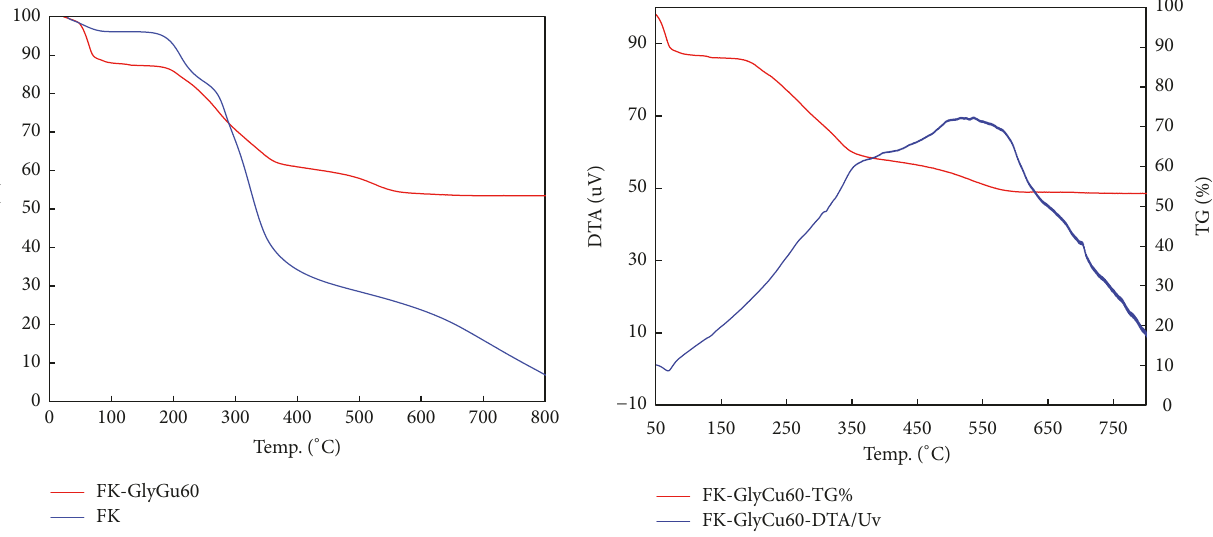
Figure 2: The TG of FK and FK-GlyCu 60 .